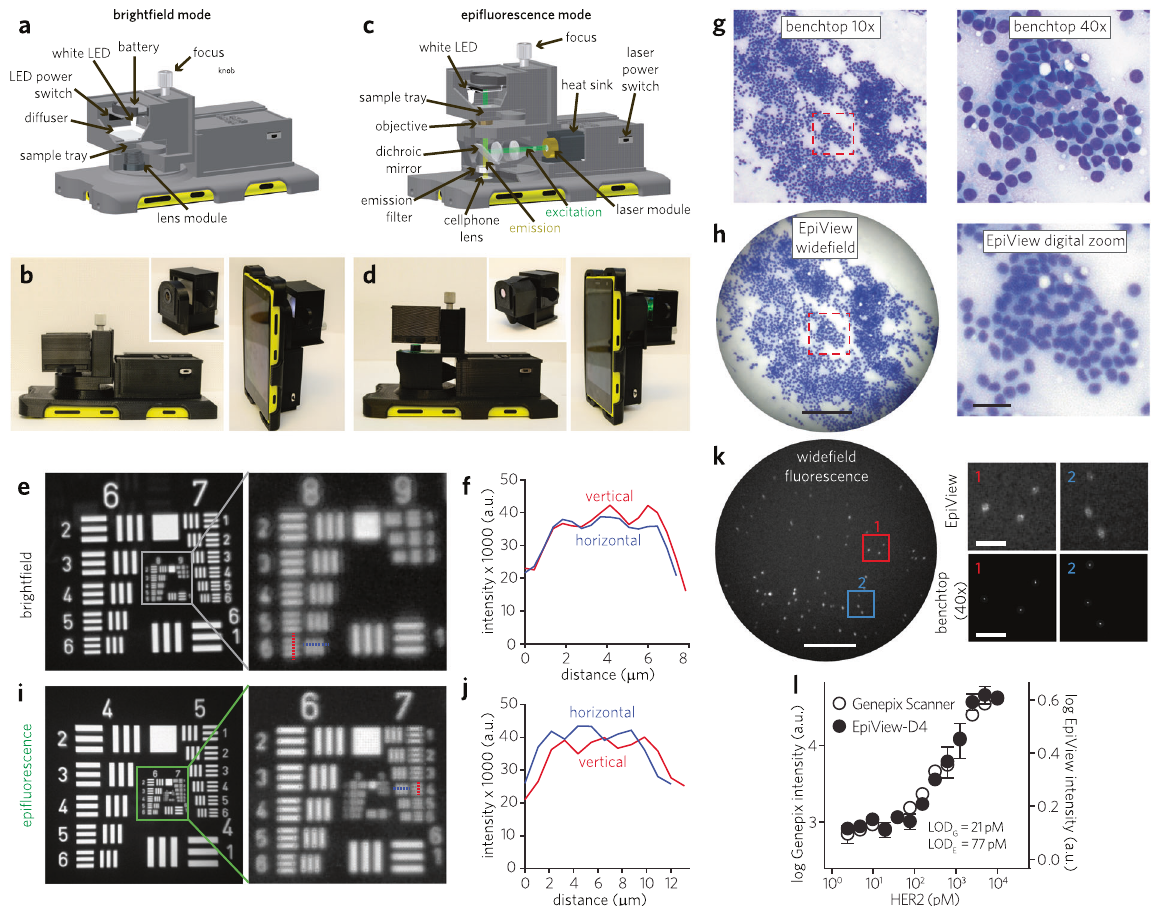
Fig. 3 EpiView mobile microscope for bright fi eld and fl uorescence imaging. a – d Optomechanical design of EpiView. Labeled 3D schematic and photographs of the EpiView scope with bright fi eld ( a , b ) and epi fl uorescence ( c , d ) assemblies. e , f Raw resolution of bright fi eld imaging from unprocessed images of USAF 1951 test target. Bright fi eld images of test target (green channel extracted) are shown in e , with red and blue dashed lines in image corresponding to vertical (red) and horizontal (blue) intensity pro fi les of test target features in f . Comparison of bright fi eld imaging of FNA cytology from human breast cancer specimen using standard benchtop microscopy ( g ) and EpiView device ( h ). Left panels: standard microscope image obtained by a 10× objective lens (top) and native view on EpiView (bottom). Scale bar, 0.2 mm. Right panels: standard microscope image obtained by a 40× objective (top), showing the same ROI outlined with red dashed line in the 10× image, and similar view obtained by digital zoom on EpiView (bottom). Scale bar, 30 µm. i , j Resolution testing with USAF 1951 in a manner similar to e and f but in epi fl uorescence mode based on extracting green channel image. k Left panel: Wide fi eld view of 200 nm fl uorescence beads using EpiView in epi fl uorescence mode. Scale bar, 0.1 mm. Right panel: Comparison of EpiView versus and benchtop microscope (40× objective, NA = 0.6) of the 200 nm beads outlined by the red and blue ROIs in the wide fi eld image. Images were extracted from green channel. Scale bars, 40 µm. l Dose-response curve of HER2 with D4-EpiView and a conventional glass slide scanner. Limit of detection for this experiment using conventional glass scanner (LOD G ) is 21 pM, while that of the D4-EpiView (LOD E ) is 77 pM. Data represent log signal intensity ± s.d for duplicate assays for both EpiView-D4 and the slide